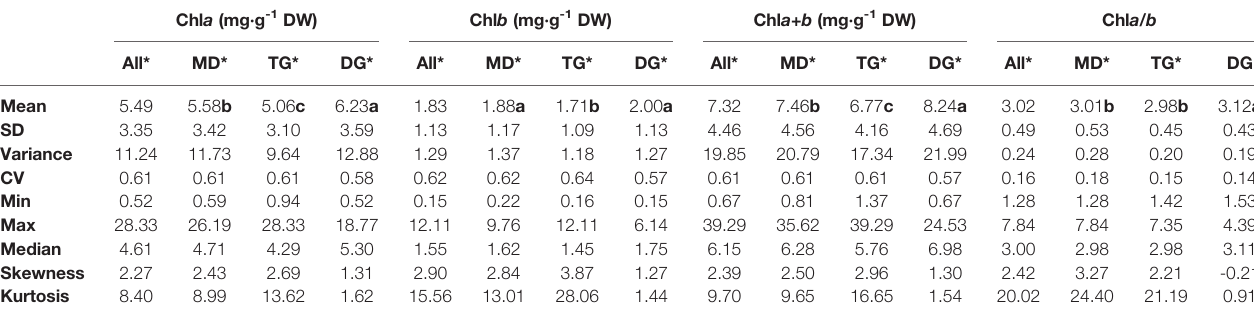
TABLE 3 | Eigen-values of frequency distributions of chlorophyll concentrations by dry weight (DW) and ratio grouped by grassland types. Chl a (mg·g -1